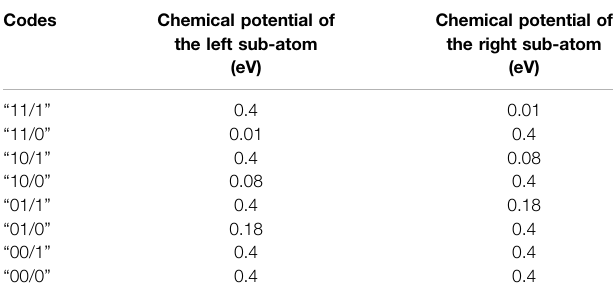
TABLE 1 | The chemical potential of the left sub-atom and right sub-atom for different codes. Codes Chemical potential of Chemical potential of the left sub-atom the right (eV)